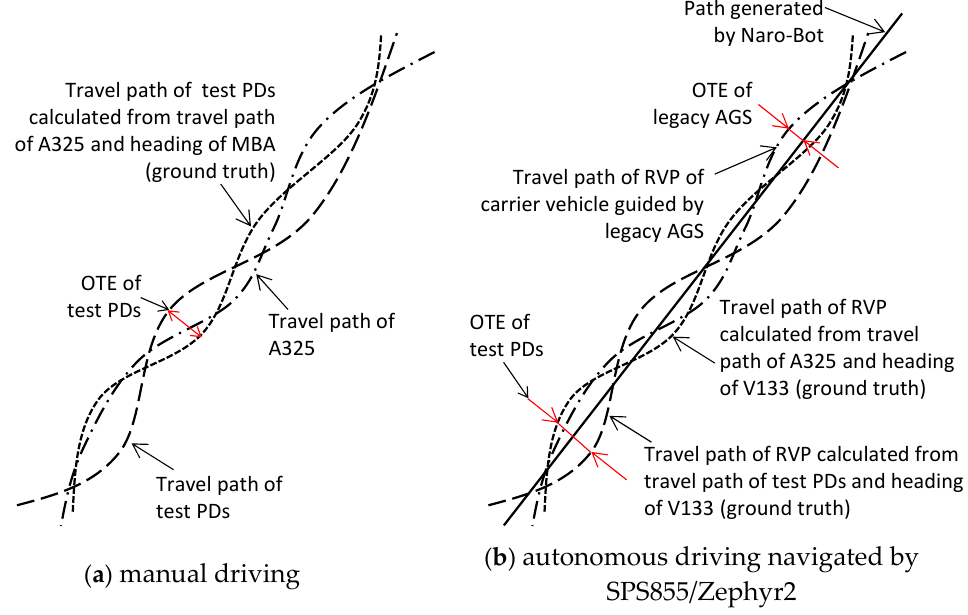
Figure 4. Definition of the OTE of the test PDs in different driving modes. The horizontal positioning accuracy of the test PDs was represented by cross-track accuracy (XTA), which is the square root of two times the mean plus the standard deviation of OTEs of all navigation data that fall along the centermost of the 50-m portion of the straight segments of the travel courses. The U-turn accuracy (UTA), which is the dynamic performance determined from OTEs occurring during the traverse of a 180° turn, was represented by the square root of two times the mean plus the standard deviation of all OTEs that occur along the U-turn segments and the first 20 m of the straight segment following the turns (ISO, 2010).